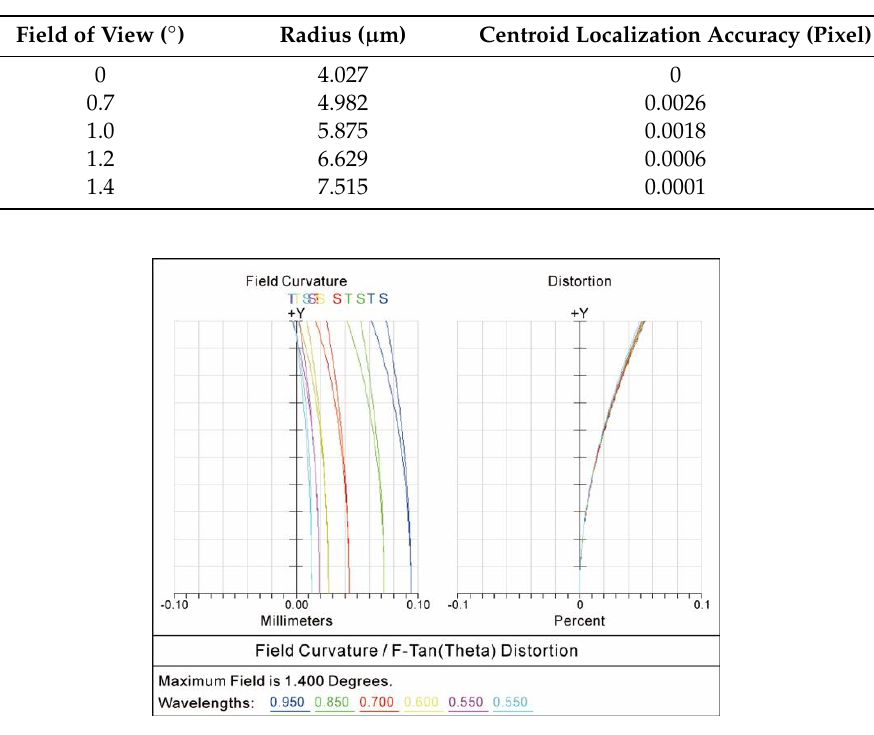
Figure 5. Relative distortion curves.